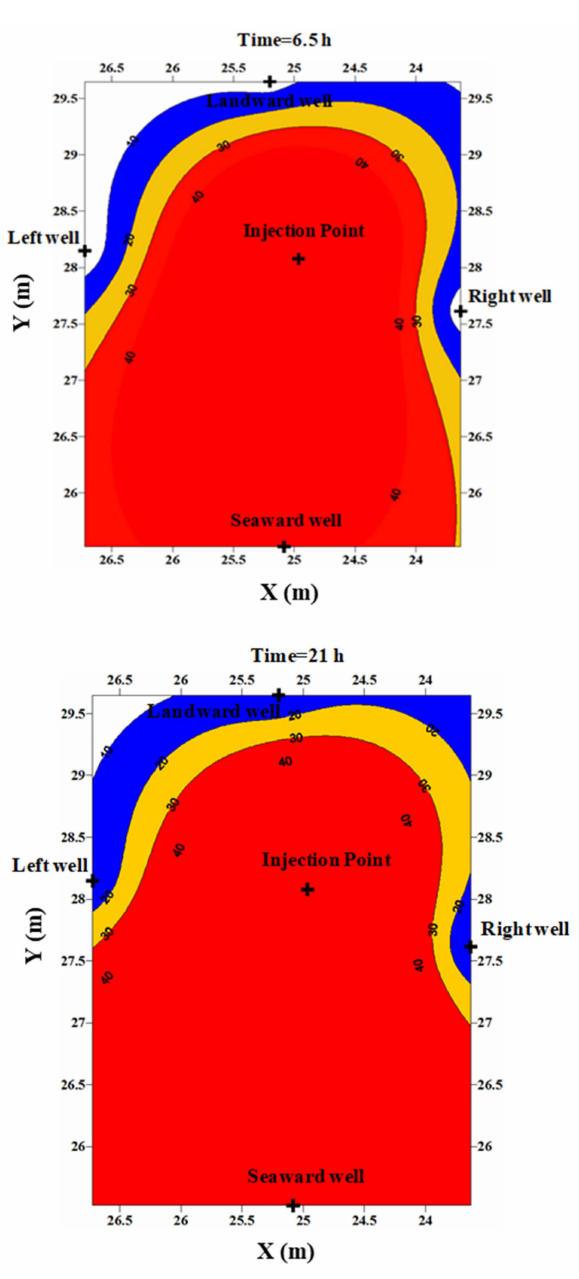
Figure 8. Empirical contours of lithium concentration as a percentage of the maximum at two di ff erent times, 6.5 and 21 h. The injection point was at the approximate location x = 25 m, y = 28 m. The edge of the plume was delineated where the concentration was 10% of the maximum. The figure indicates that at t = 21 h, the injected plume occupied an approximate area of 12 m 2